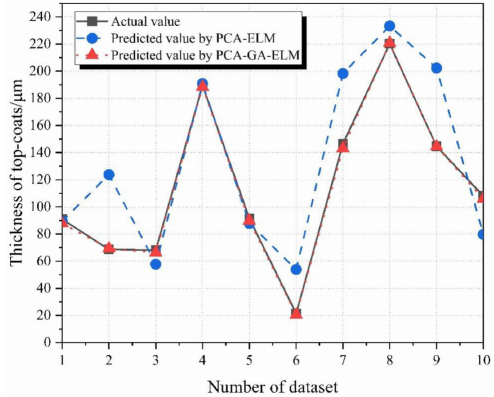
Figure 8. Relationship curve between fitness and evolution generation.